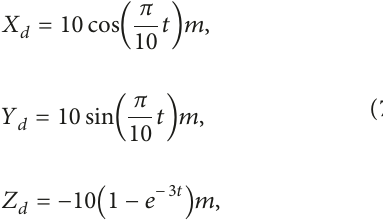
Figure 5: Contrastive results of output y under the proposed controller and the adaptive FTC method